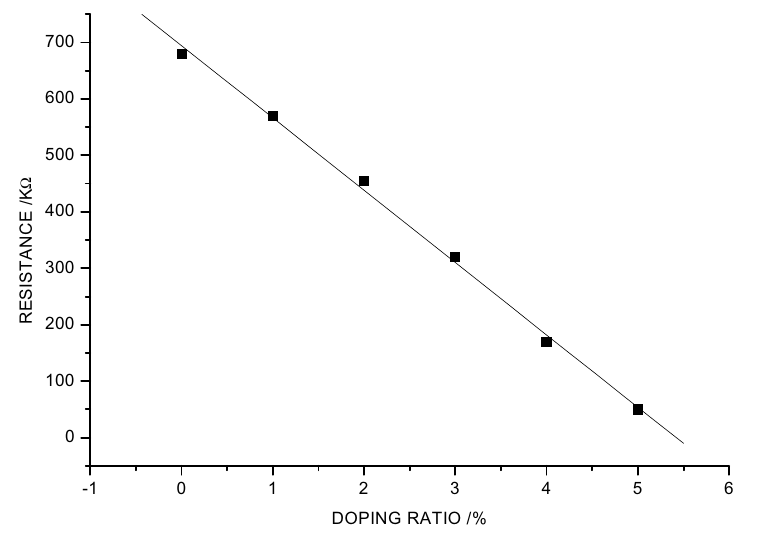
Figure 4. Relationship between Ag doping ratio and sensor’s resistance.